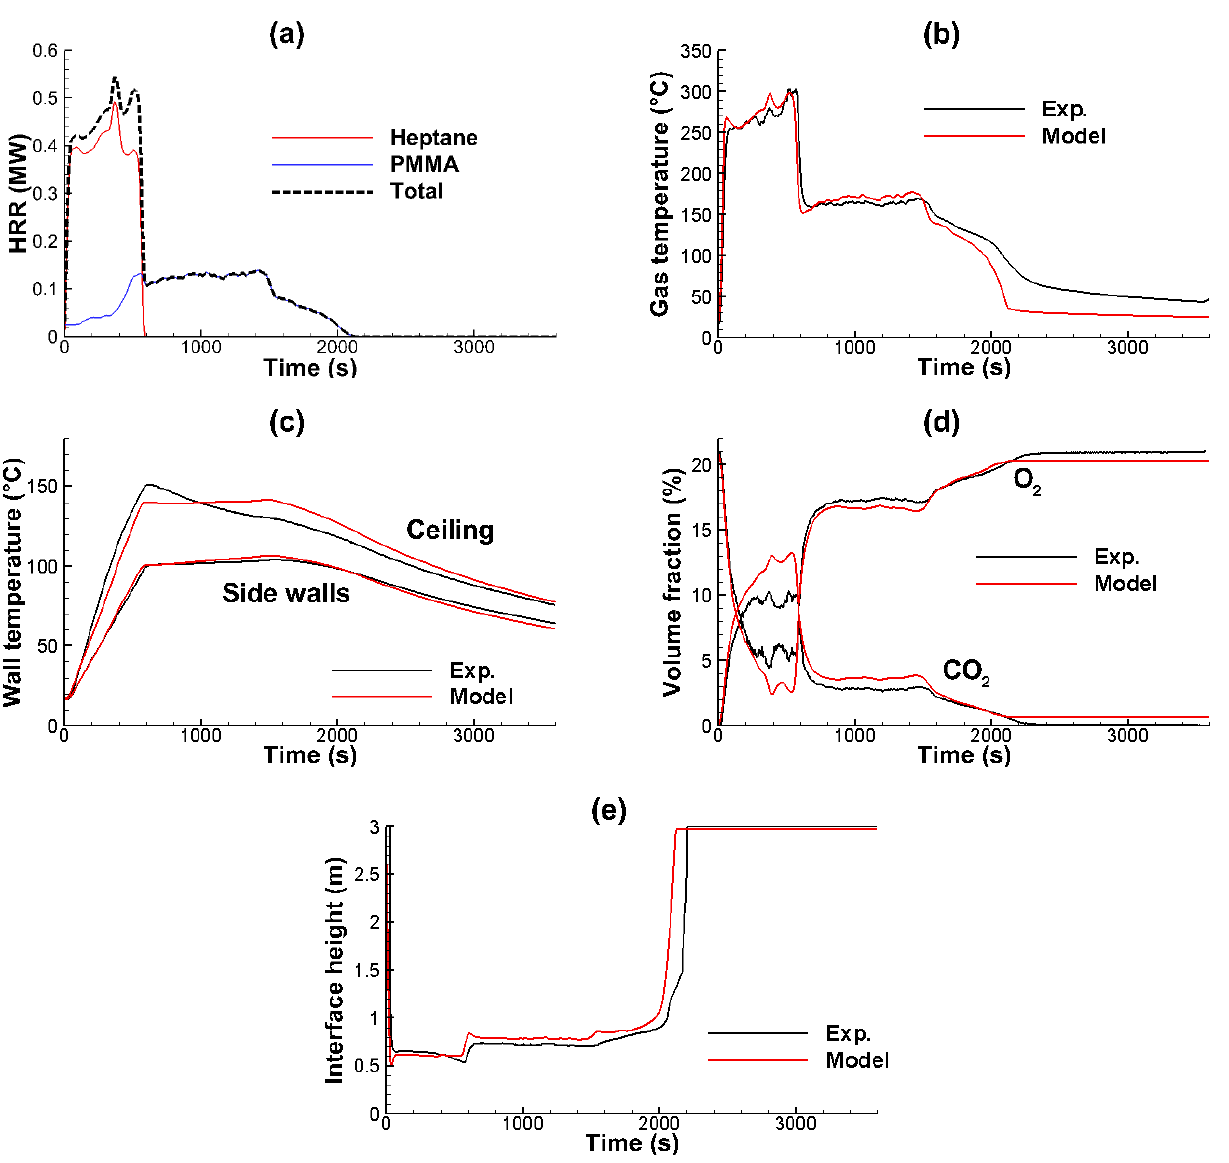
Figure 11. Test 3: ( a ) individual and total HRRs, ( b ) average gas temperature, ( c ) average wall temperatures, ( d ) volume fractions of O 2 and CO 2 in the exhausted gases, and ( e ) smoke layer interface height.